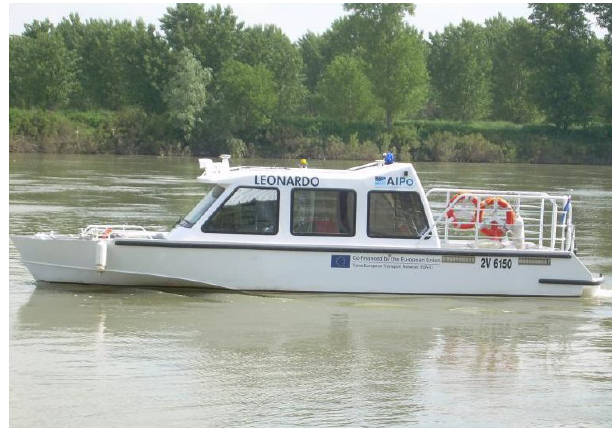
Figure 6. Monitoring vessel Leonardo , courtesy of the Po River Agency (W.A.T.E.R.